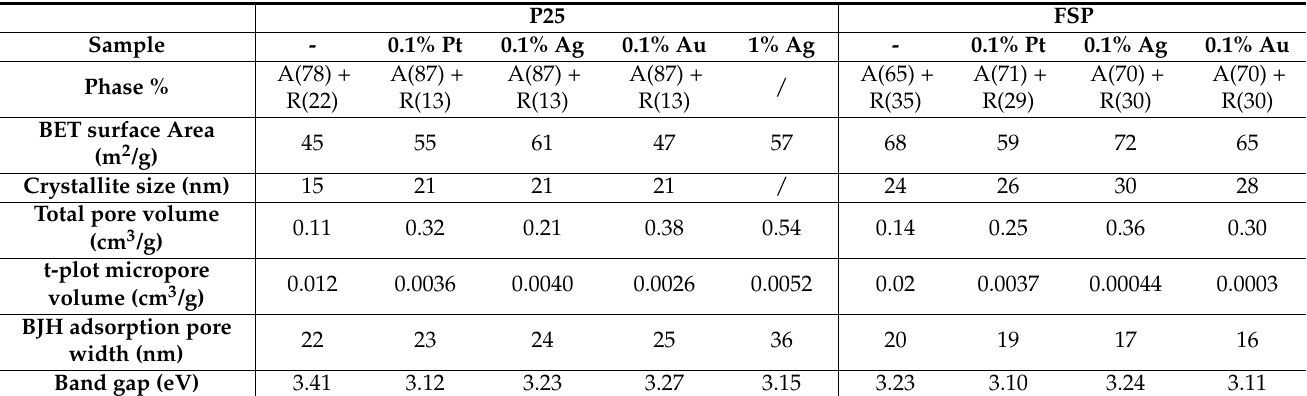
Table 1. Results of the characterisation analysis of selected